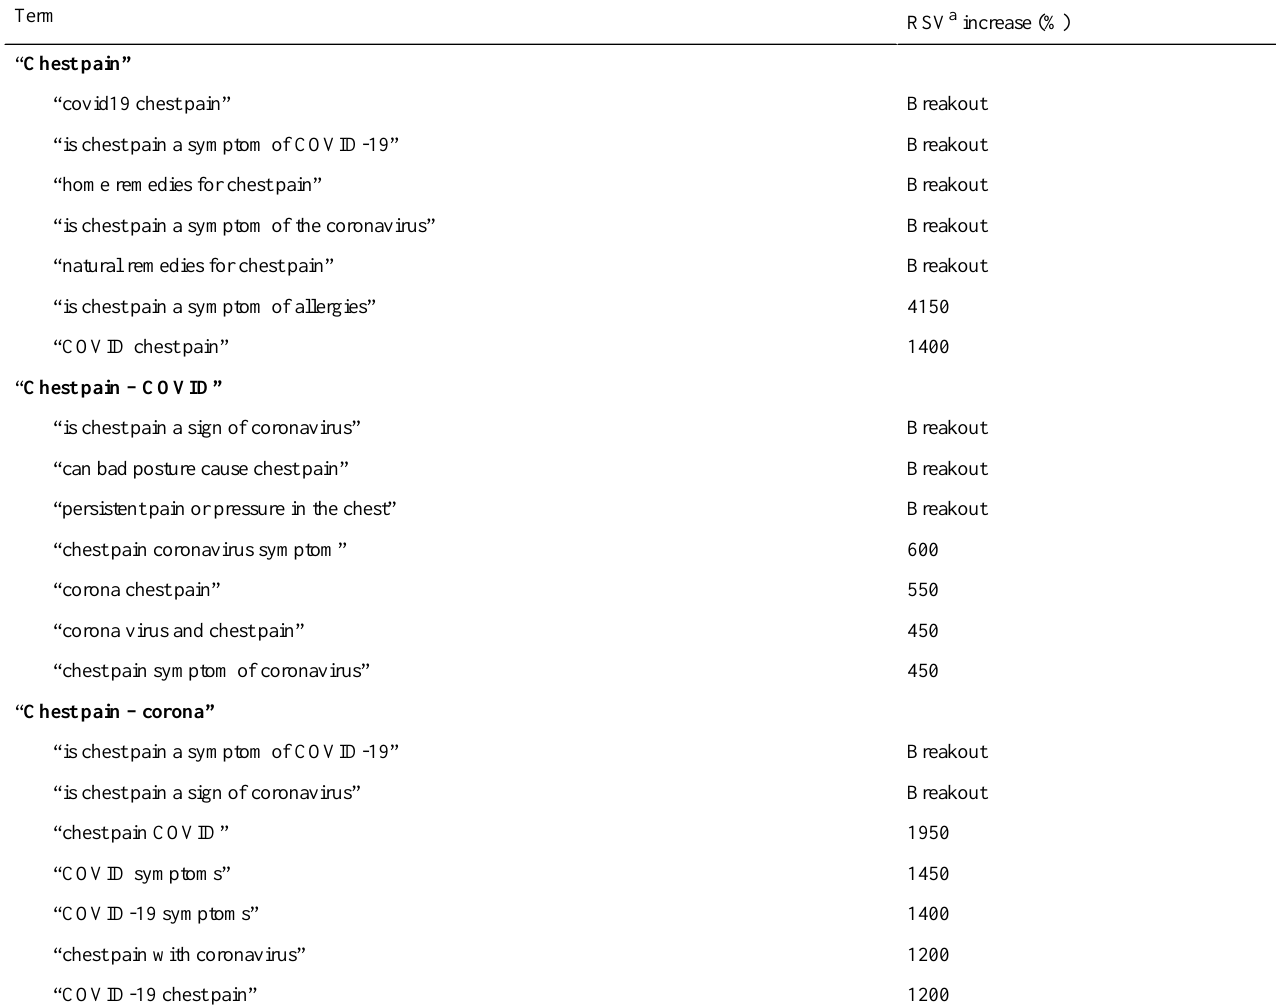
Table 2. Rising chest pain–related queries from March 15, 2020, to April 15, 2020, United